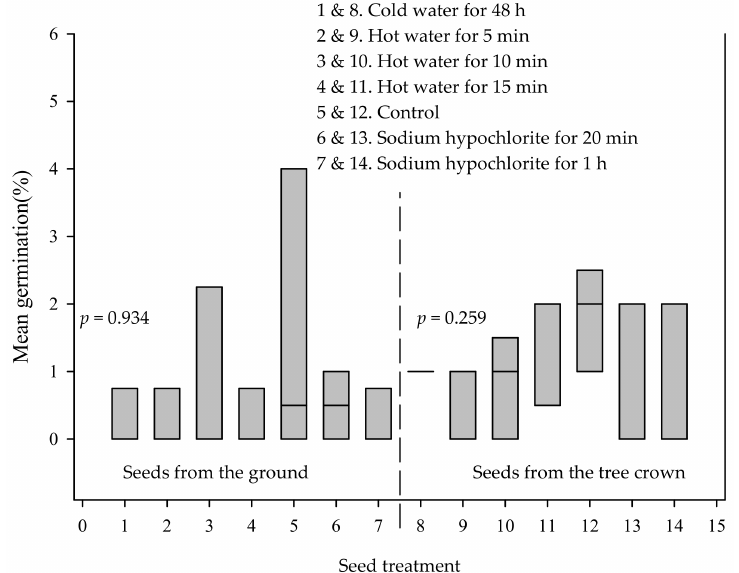
Figure 7. One-way ANOVA results of the mean germination of D. steudneri seeds evaluated in the greenhouse, collected from the ground (graph on the left ) and directly from the tree crown (graph on the right ) with different seed-dormancy-breaking treatments.